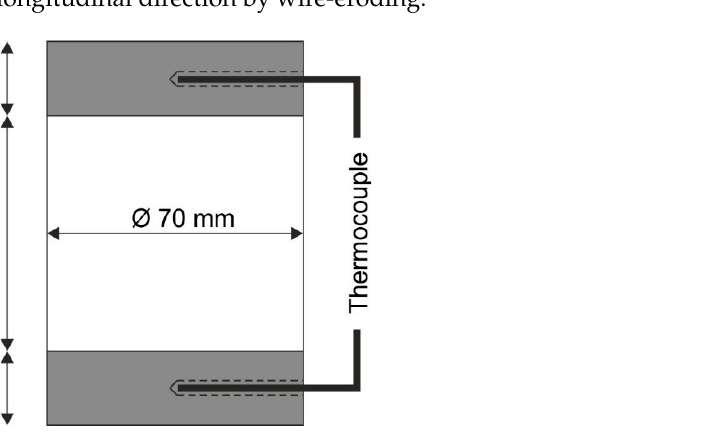
Figure 1. Geometry of the HIP capsule used for the in situ temperature measurements of the steel X2CrNiMoCuWN25-7-4.